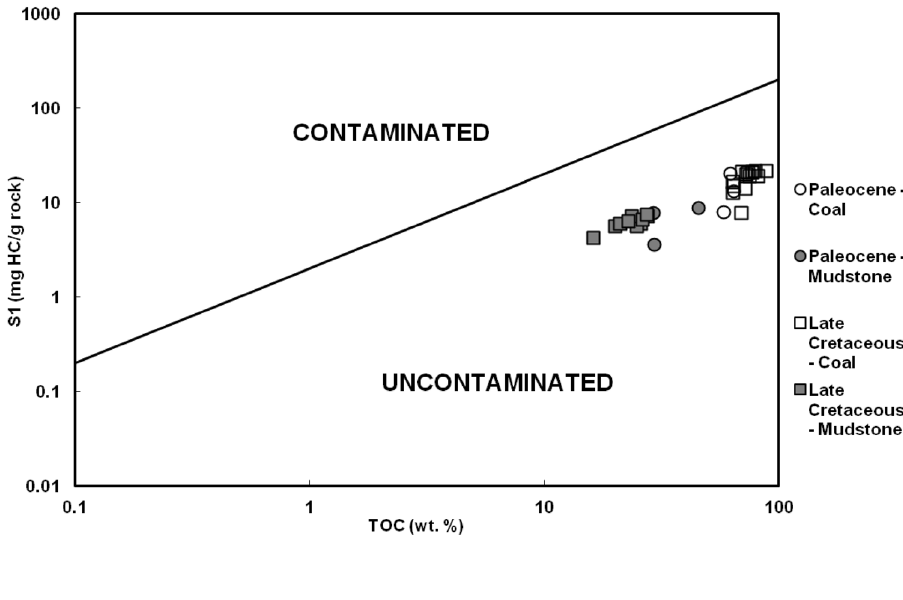
Fig. 4 A cross-plot of produc- tion yield (PY) versus total organic carbon (TOC) to exhibit the generating potential of the Taratu